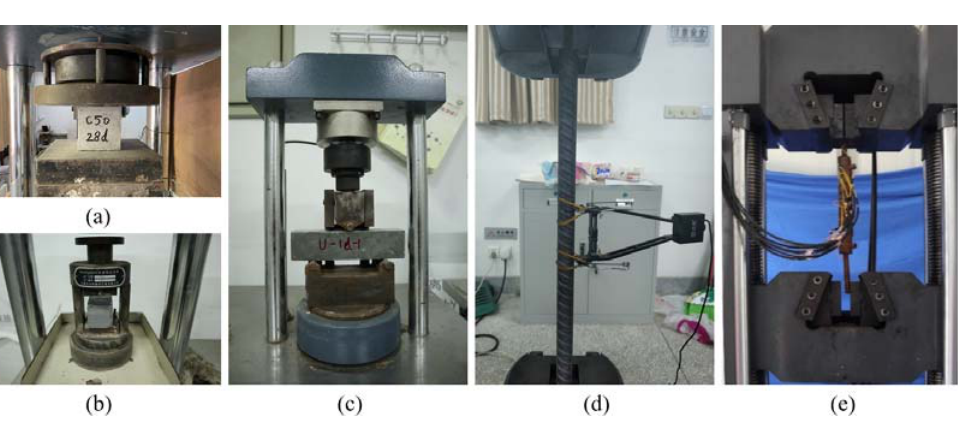
Figure 5. Mechanical property tests: ( a ) concrete; ( b , c ) grout; ( d ) rebars; ( e ) grouted sleeve.